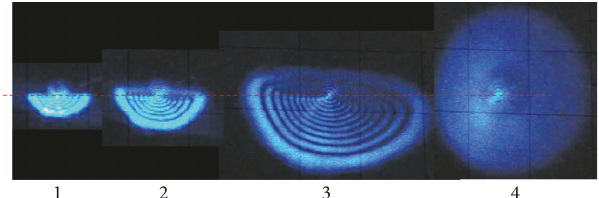
Figure 4: The trace profile of a converging optical beam at different positions of the nonlinear medium along the z